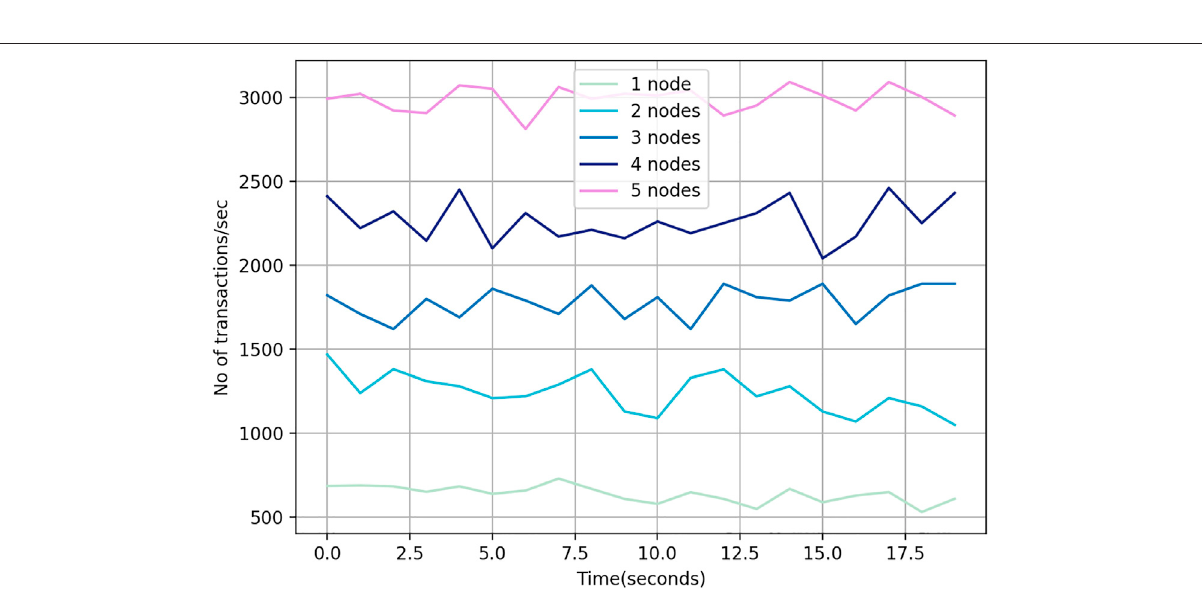
Frontiers in Blockchain |